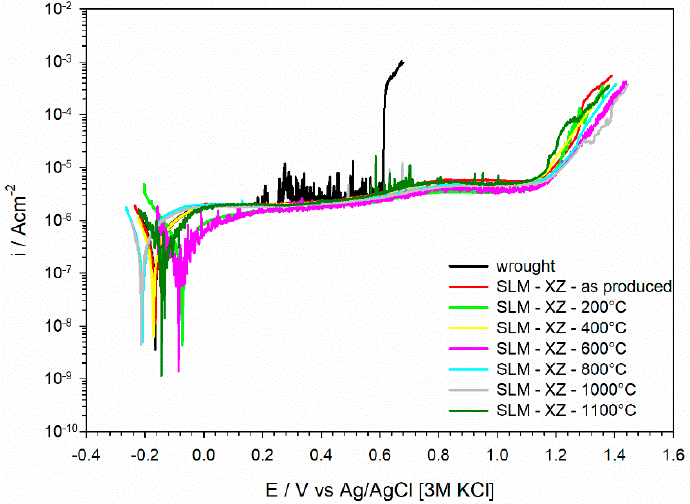
Figure 7. Potentiodynamic polarization curves in neutral 3.5% NaCl solution.